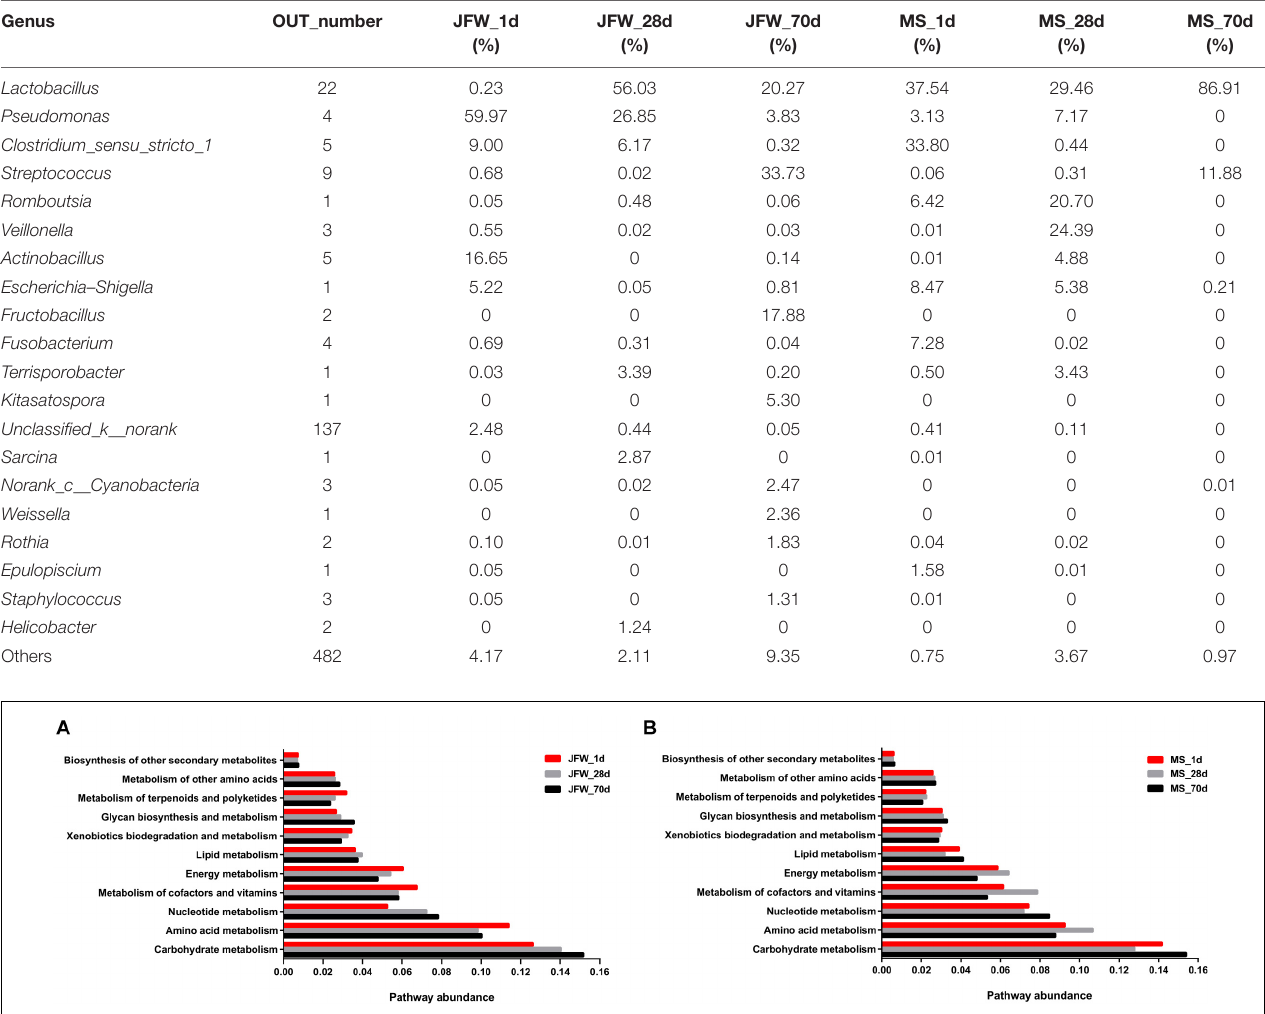
TABLE 3 | The ratio of identified genera at different developmental stages of Jinfen White and Mashen piglets. Genus